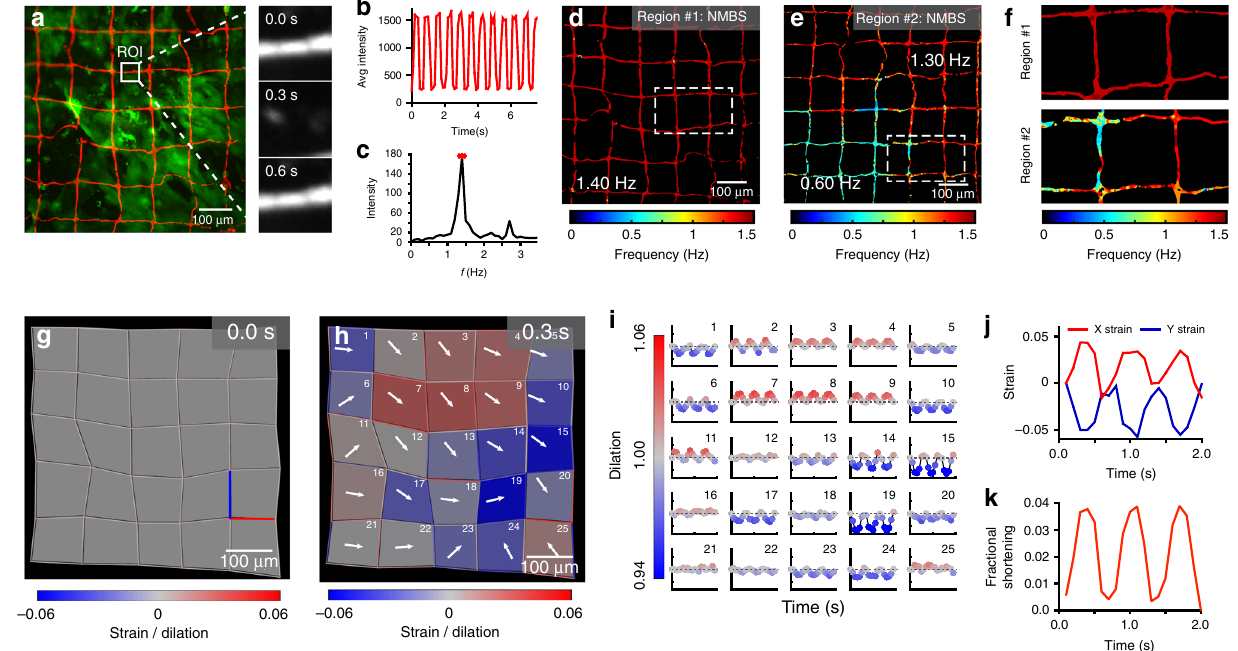
Time (s) Fig. 4 Beat frequency analysis and strain mapping during cardiomyocyte contractions. a Fluorescence image of representative Alexa-555 fi bronectin NMBS (Red, 100 µ m × 100 µ m × 10 µ m) applied to iPSC-derived cardiomyocyte monolayer loaded with Fluo-4 calcium indicator dye (Green). White box indicates ROI for NMBS motion analysis. Motion analysis of ROI displays NMBS segment moving in and out of the ROI over time. b Quanti fi cation of the average fl uorescence intensity from the ROI through time. c Example power spectral density plot from the Fourier transformed data of a NMBS ROI segment showing the intensity at each frequency with a dominant frequency of 1.4 Hz. d A synthetic image is constructed containing the frequency information of every pixel within the NMBS to visualize variability of contractile frequencies for cardiomyocyte monolayers. A dominant uniform frequency of 1.4 Hz is observed. e Example region #2 of contractile cardiomyocytes demonstrating heterogeneous beat frequencies of 1.3 and 0.6 Hz. f Magni fi ed images of region #1 and #2 demonstrating differences in heterogeneity between fi elds. g , h Time-series showing regional dilation and NMBS segment strain throughout a contraction cycle of diastole and systole. Displacement vectors (white arrows) for each square region de fi ned by the NMBS show the contractile direction between peak systole and diastole. i Analysis of dilation over a 2 s time interval de fi ned by the NMBS meshed regions (red = tension, blue = compression). j Quantitative analysis of example X (red line in g ) and Y (blue line in g ) strain from NMBS segments shows the tensile and compressive strain rate over time for cardiomyocytes with a beat frequency of 1.4 Hz, maximum tension of 4% and compression of 6%. k Fractional shortening is calculated from a regional dilation analysis of ROIs 13, 14, 18, and 19 demonstrating a peak fractional shortening of 3.8% ± 0.06 between diastole and systole (mean ± S.D.; n = 3 cycles over 1